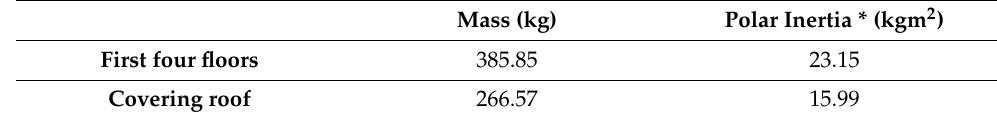
Table 1. Inertial properties of the floors.